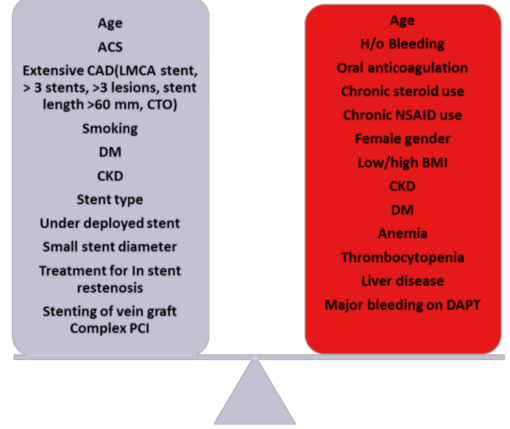
Figure 1. Balance between ischemic and bleeding risks [38,72]. ST = Stent thrombosis; ACS = Acute coronary syndrome; DM = Diabetes mellitus; CKD = Chronic kidney disease; PCI = percutaneous coronary intervention; NSAID = Non-steroidal anti-inflammatory drugs, DAPT = Dual antiplatelet therapy.